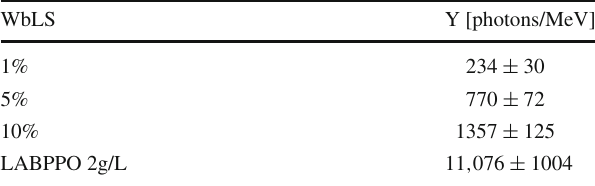
Table 1 Measured absolute light yield parameters. Statistical and sys- tematic uncertainties are included in the quoted numbers WbLS Y [photons/MeV]